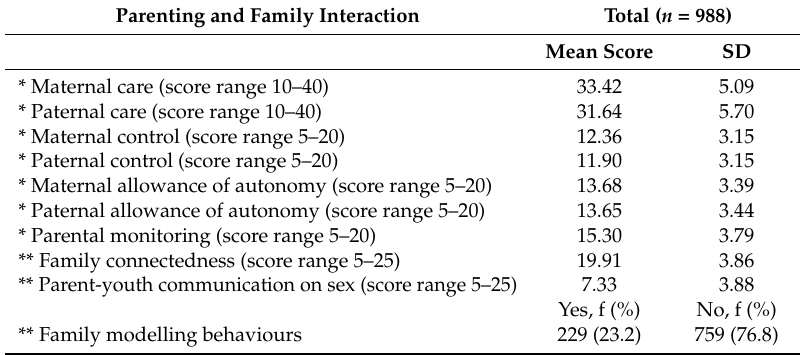
Table 1. The level of parenting behaviour and family interaction experienced by the youths. Parenting and Family Interaction